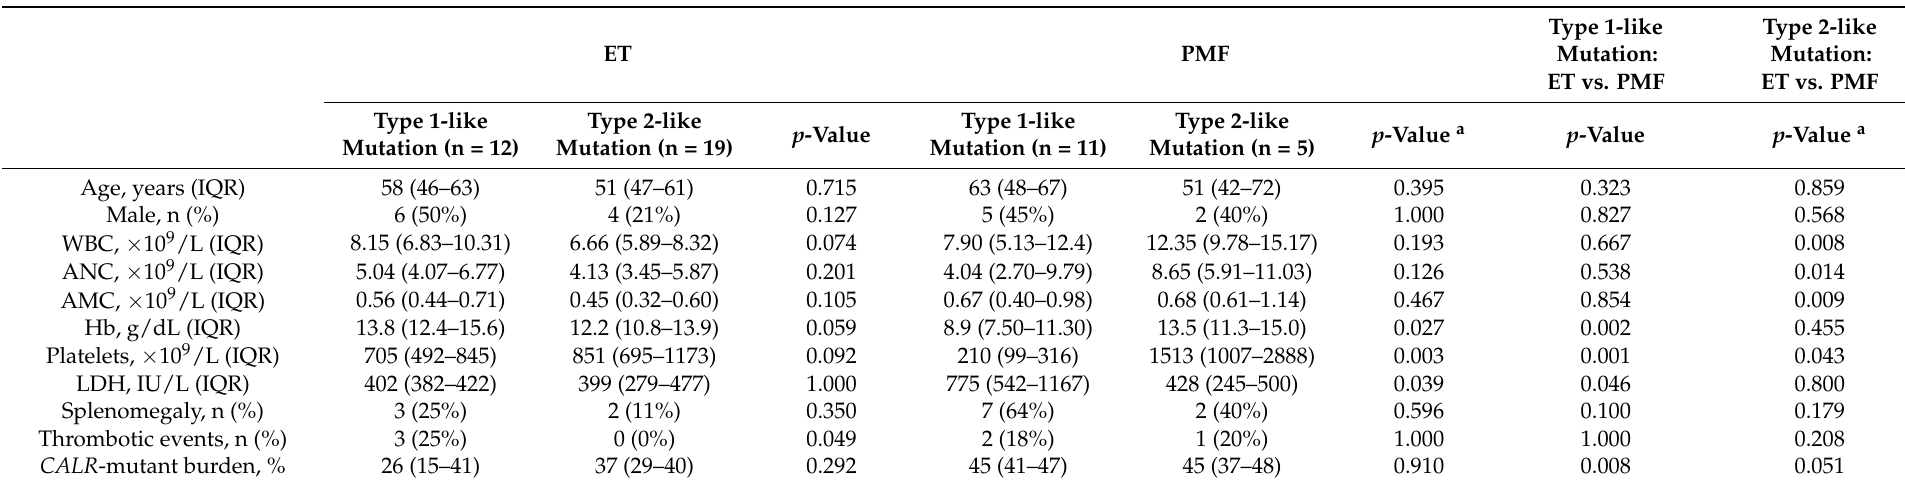
Table 4. Comparison of patients' clinical and laboratory characteristics according to the CALR mutant types in ET and PMF.